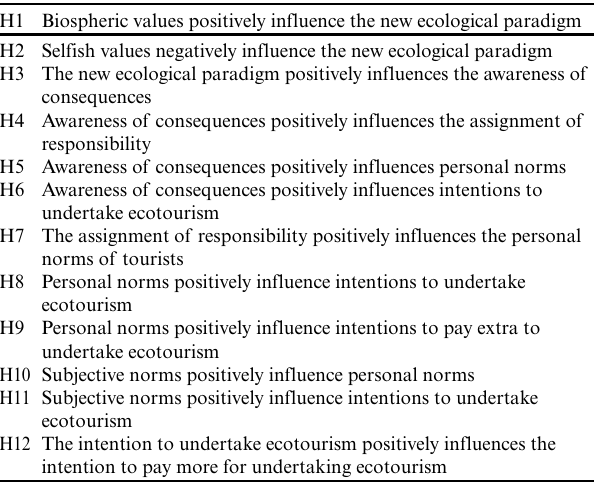
Table 2 . Hypotheses of the